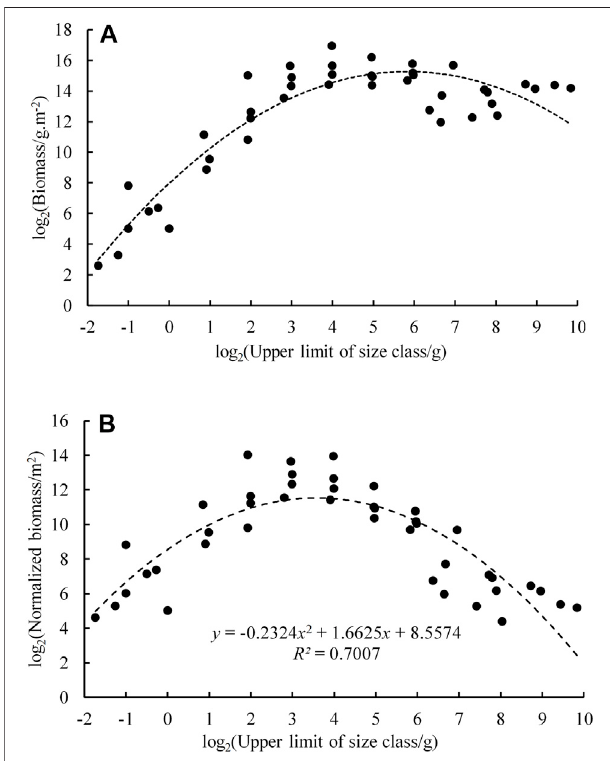
FIGURE 5 | Biomass size spectrum of fi sh in Daya Bay; a. Sheldon; b.